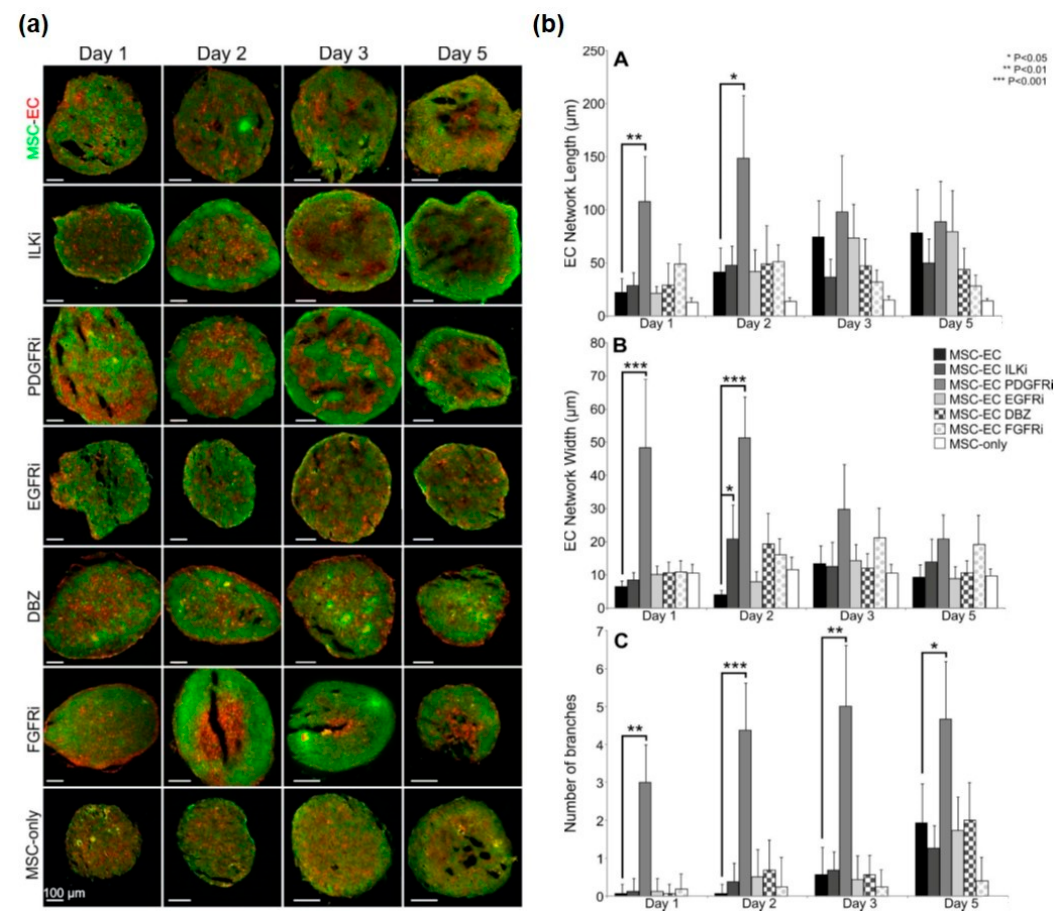
Figure 3. Effect of signalling pathway inhibitors on EC organisation in MSC:EC spheroids. ( a ) Representative sections of spheroids treated with inhibitors over 5 days in culture; MSCs are labelled green, ECs labelled red. Inhibitors targeted ILK, PDGFR, EGFR, Notch (DBZ) and FGFR signalling. MSC-only controls comprised of 50% green and 50% red MSCs. ( b ) Quantification of EC network length (A, top), width (B, middle) and branching (C, bottom) using image analysis.